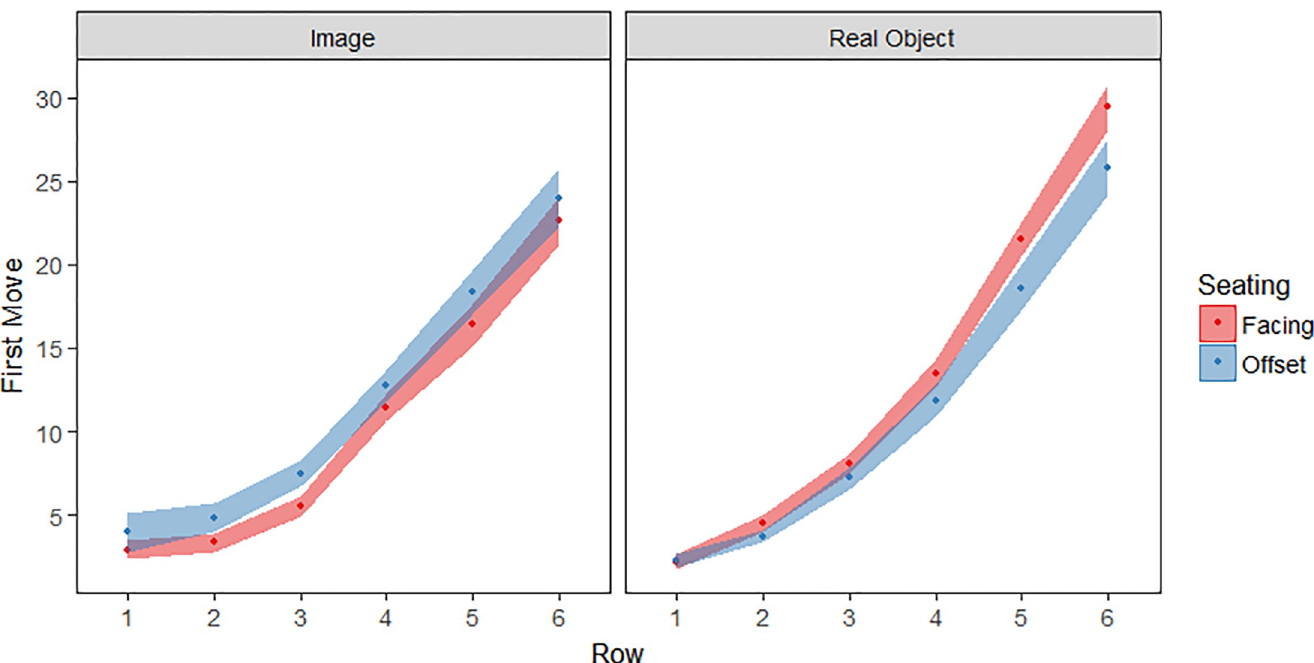
Fig 6. The number of moves ( M ± SE ) preceding first entry into each row of real objects and images. Higher values indicate that a particular location was contacted for the first time at a later point in the reaching sequence.